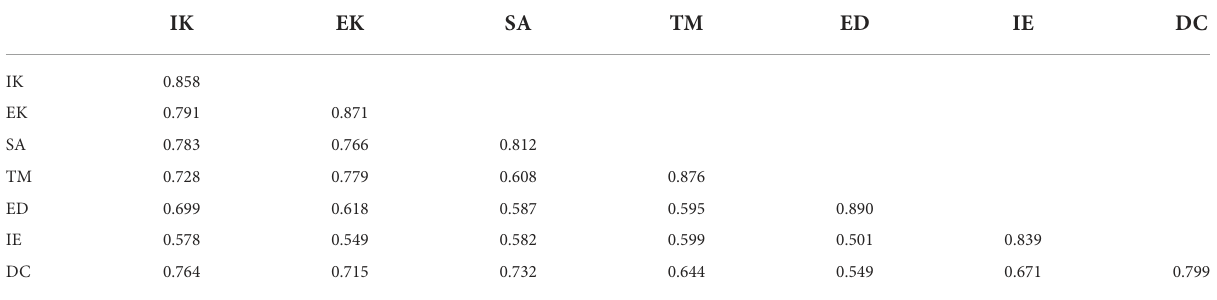
TABLE 5 Distinguishing validity: Pearson correlations and AVE square